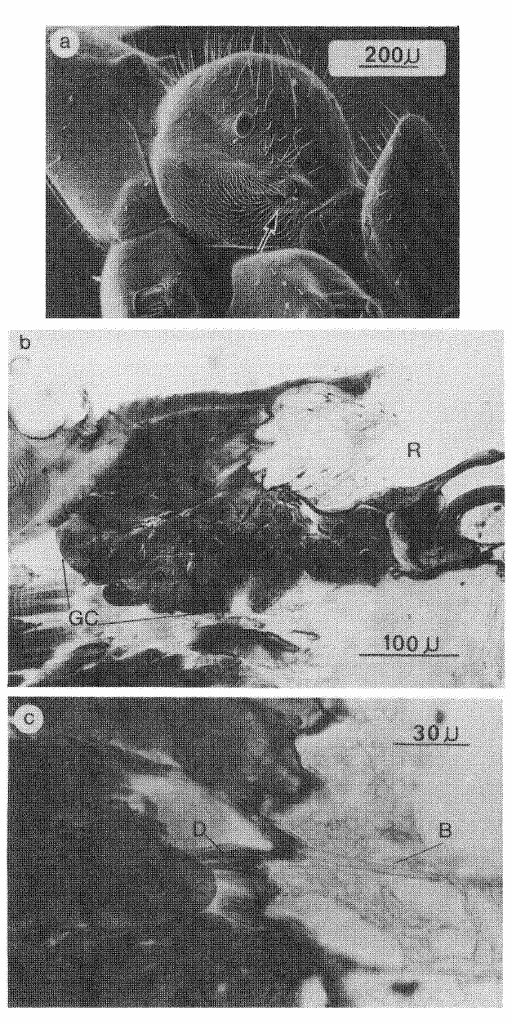
Fig. 6. The metapleural gland of a worker of lridomyrmex purpureus a. SEM micrograph of mesosoma. The arrow points to the opening of the metapleural gland. b. Longitudinal section through the metapleural gland, c. Close-up of a section through the glandular cells (GC) and dispenser bristles (B); D glandular duct; R collecting